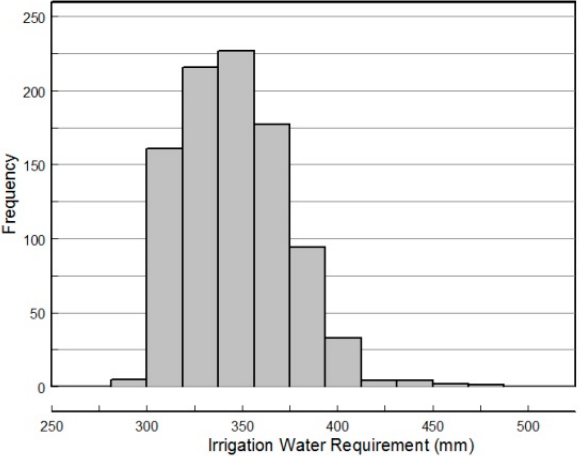
Figure 7. Frequency distribution of NDVI-dependent Irrigation Water Requirement (IWR) for the dairy farms in the Goulburn-Murray Irrigation District during summer 2015 – 2016.